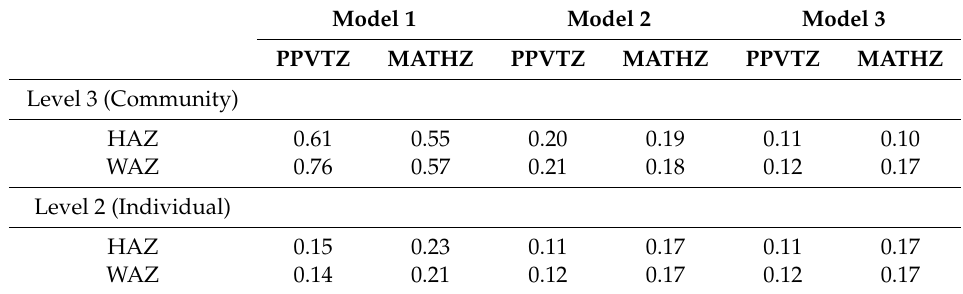
Table 5. Individual- and community-level correlation in height-for-age z-score (HAZ), weight-for-age z-score (WAZ), Peabody Picture Vocabulary Test z-score (PPVTZ), and mathematics test z-score